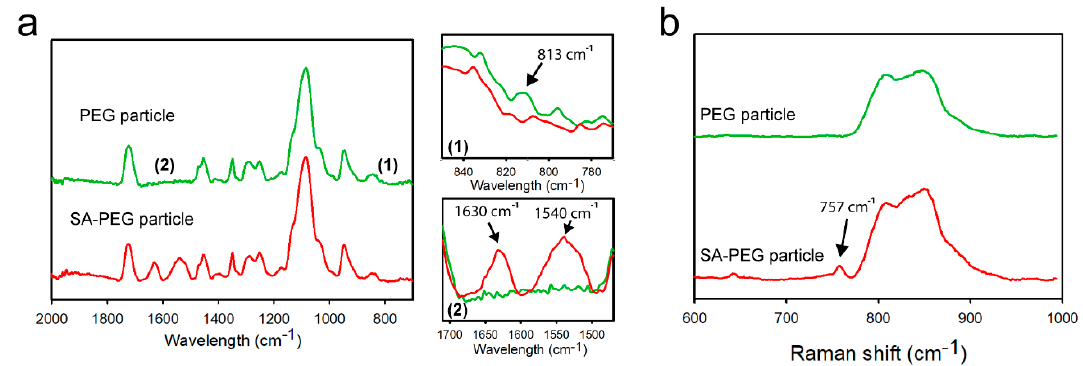
Figure 2. Spectroscopic analysis of encoded hydrogel microparticles: ( a ) FTIR spectra in the 700–2000 cm − 1 region of encoded hydrogel microparticles before and after the reaction with streptavidin. ( b ) Raman spectra in the 600–1000 cm − 1 region of encoded hydrogel microparticles before and after the reaction with streptavidin.